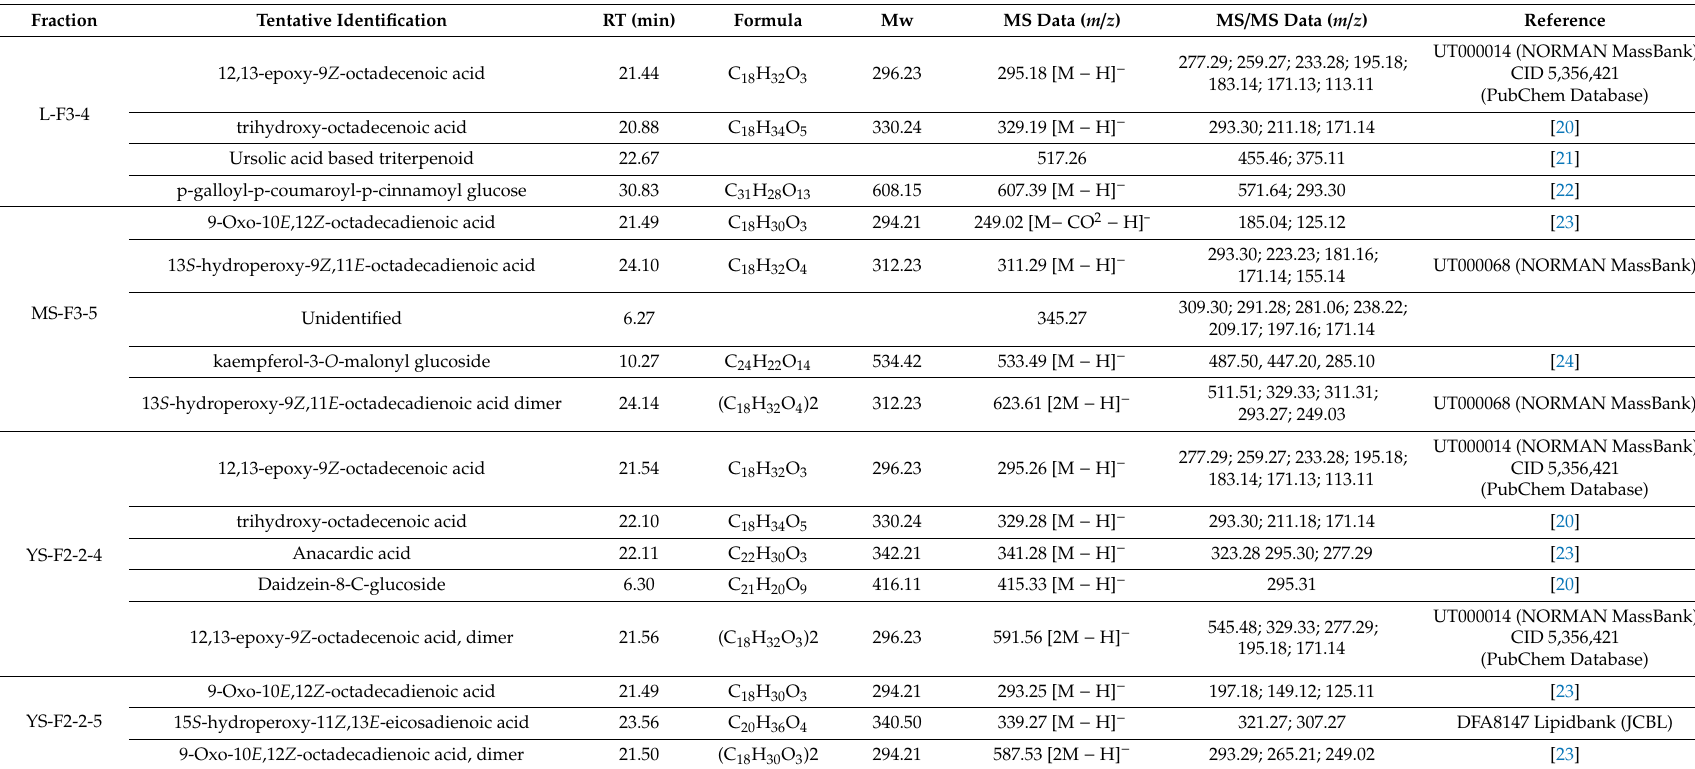
Table 3. LC-MS analysis of active subfractions L-F3-4, MS-F3-5, YS-F2-2-4 and YS-F2-2-5: tentative identification, retention time, molecular formula, molecular weight (Mw), m / z